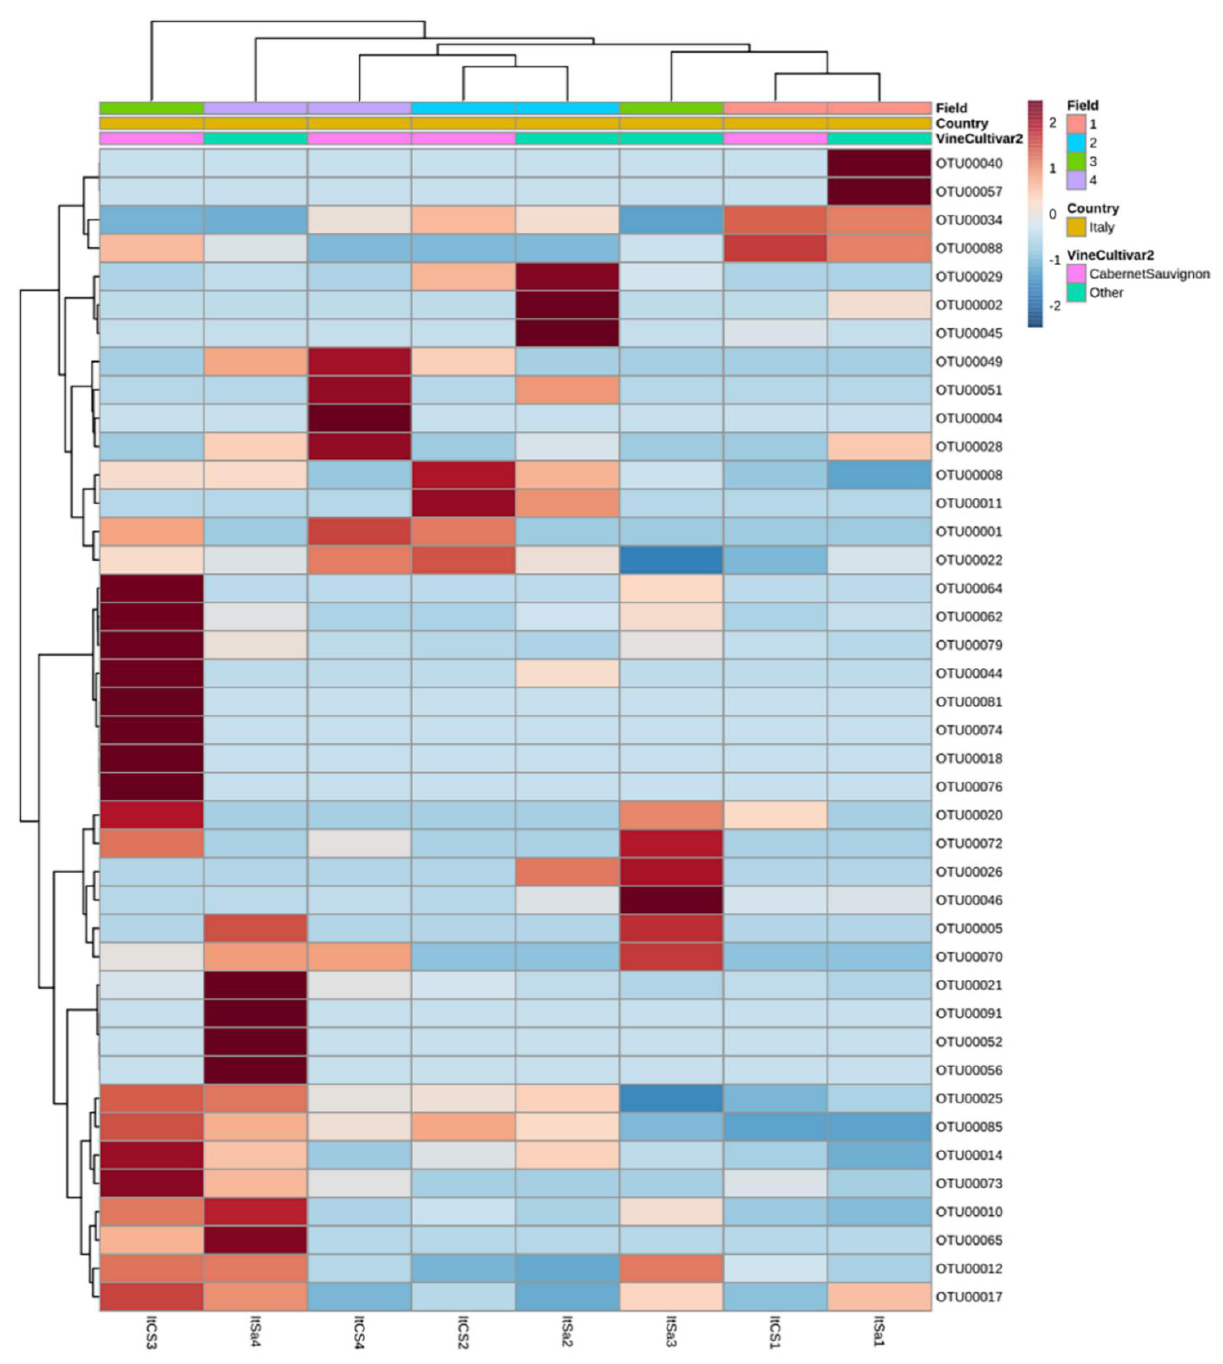
Figure A7. Clustered heatmap showing the variation of taxonomic abundance with regard to Italy (country) and cultivar samples [Cabernet Sauvignon and others (local cultivar)]. Sample code: It, Italy; CS, Cabernet Sauvignon; Sa, Sangiovese.